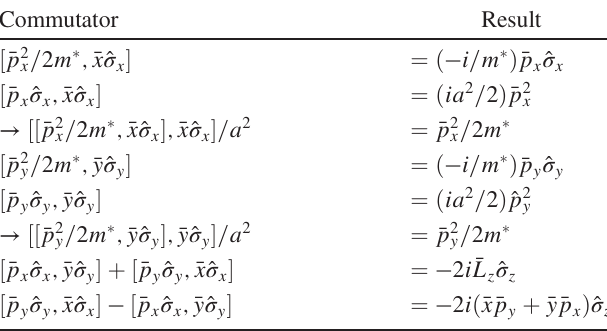
TABLE IV. Commutator